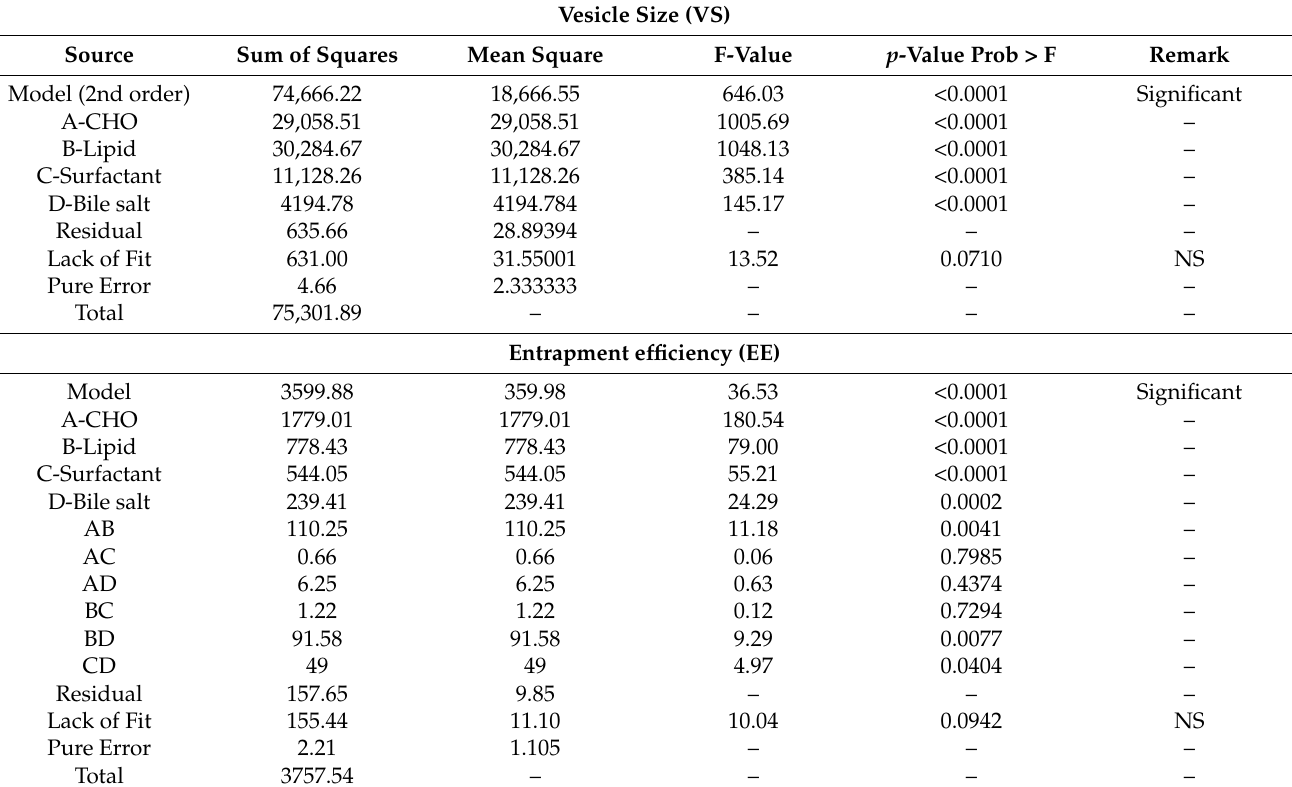
Table 3. ANOVA of best fitted designing model for vesicle size (Y 1 ) and entrapment efficiency (Y 2 ). Vesicle Size